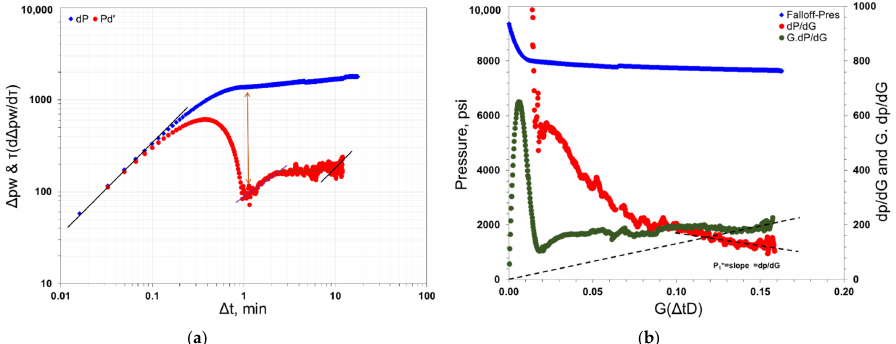
Figure 14. (a) Case #3, Bourdet pressure derivative plots for the main hydraulic fracture treatment for W2. (b) Case #3, G-function plots for the main hydraulic fracture treatment for W2.